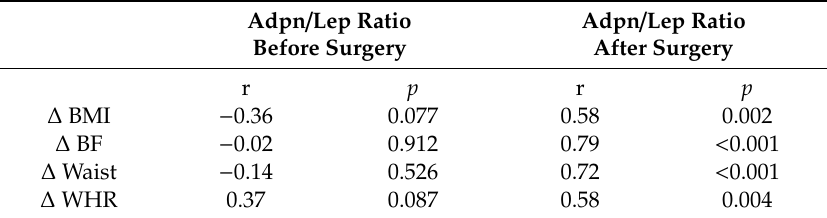
Table 2. Univariate analysis of the correlations between the adiponectin / leptin ratio before and after Roux-en-Y gastric bypass (RYGB) with changes in anthropometric characteristics. Adpn / Lep Ratio Adpn / Lep Ratio Before Surgery After Surgery r p r p ∆ BMI − 0.36 0.077 0.58